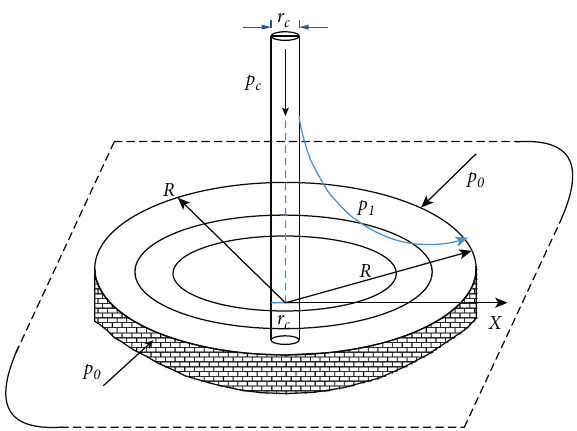
Figure 5: Schematic of the calculation model for di ff usion radius of pressurized